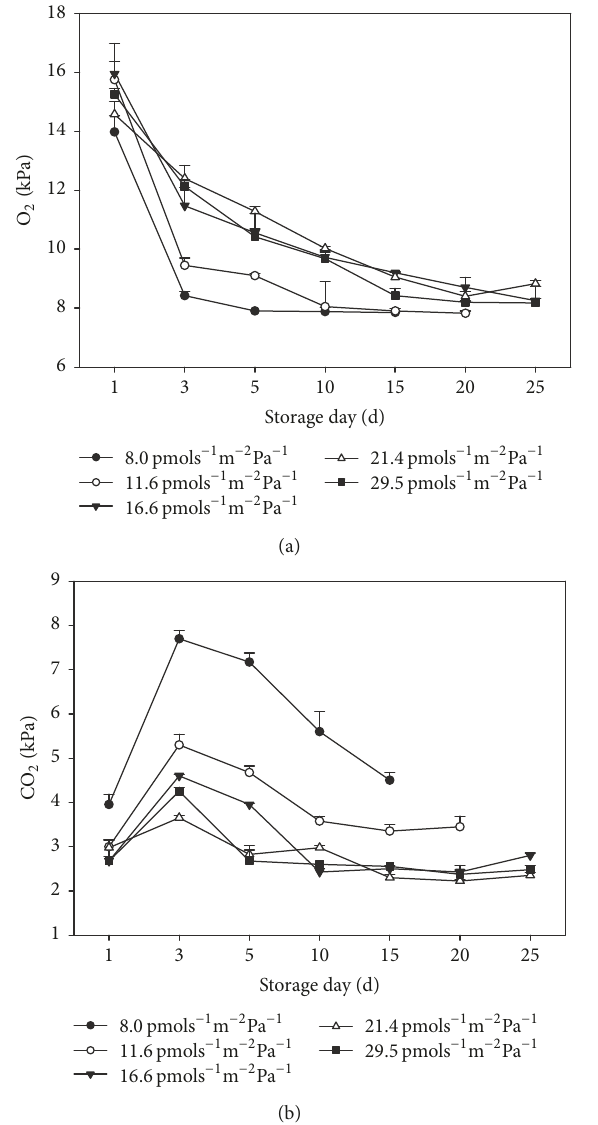
Figure 2: Color changes of Chinese toon tender shoots during storage at 4 ∘ C in packaging with various levels of OTR, expressed as changes in 𝑎 ∗ and hue angle values. Data points represent the mean ± SE ( 𝑛 = 80